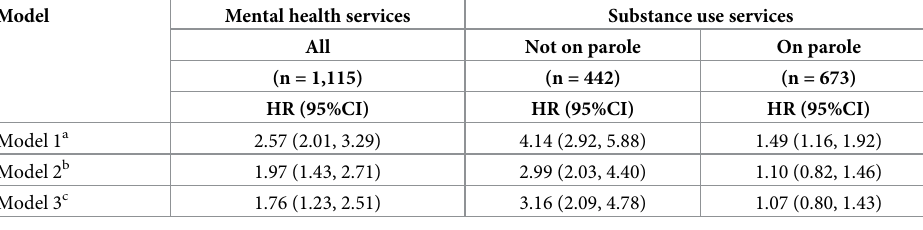
Table 3. Effect of mental health and substance use treatment services on hazard of